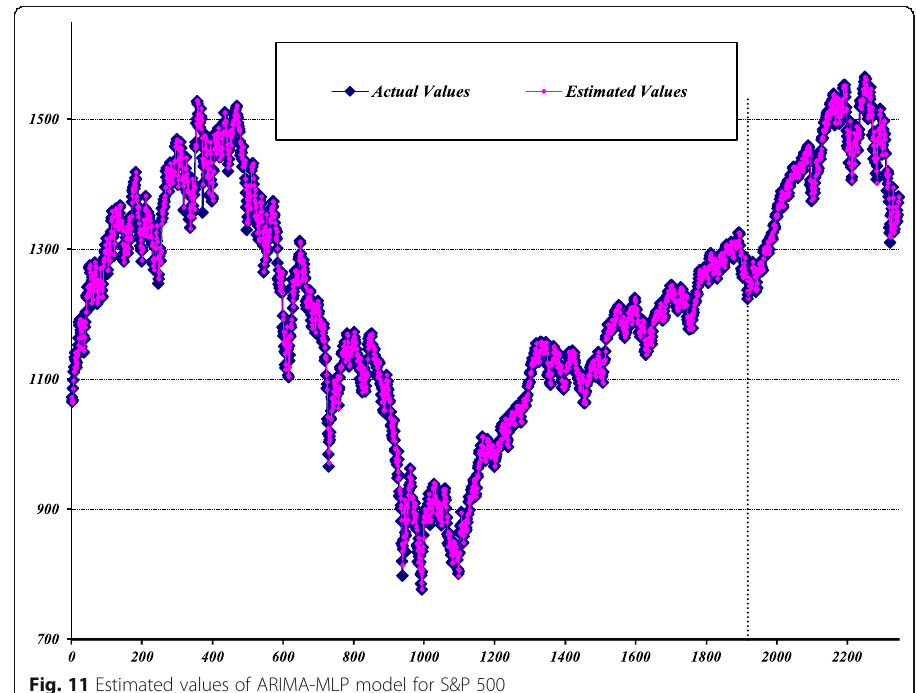
Fig. 11 Estimated values of ARIMA-MLP model for S&P